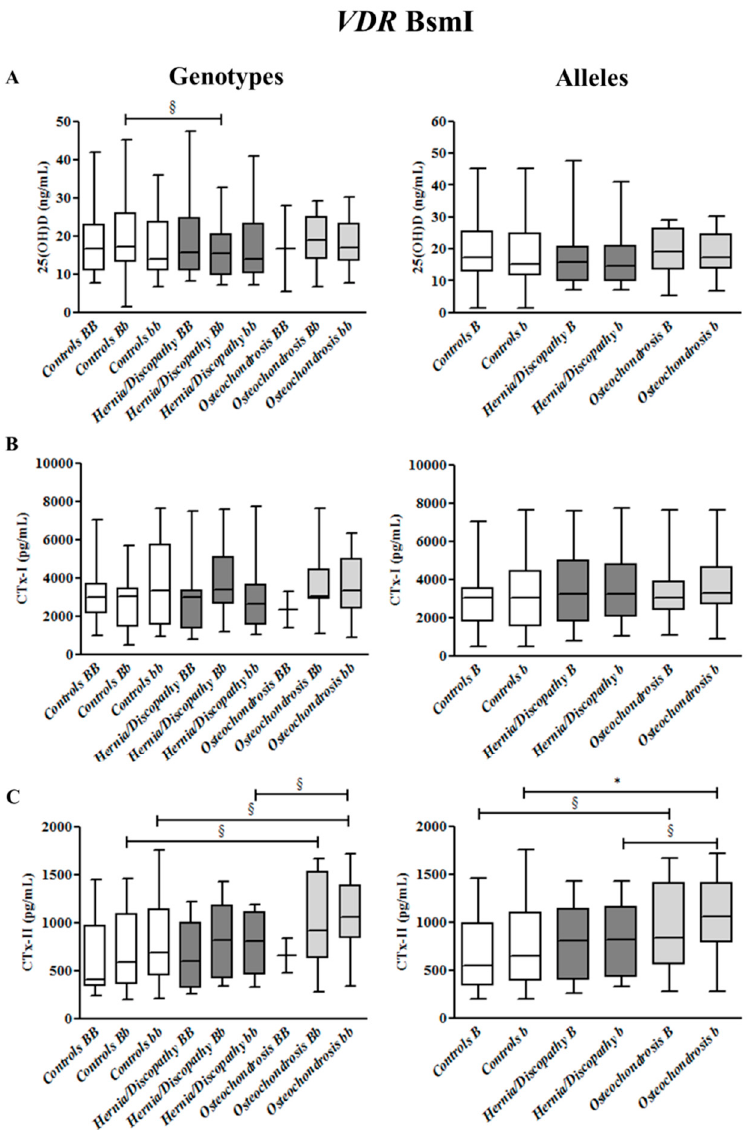
Figure 2. 25hydroxyvitamin D (25(OH)D) ( A ), cross-linked C-telopeptides of type I collagen (CTx-I) ( B ), and cross-linked C-telopeptides of type II collagen (CTx-II) ( C ) plasma concentrations in controls and in the subgroups of patients with hernia/discopathy and osteochondrosis, distributed according to BsmI VDR genotypes/alleles. The box and whisker plots show the median, 25th and 75th percentile (interquartile) (the box), and minimum and maximum value (the whiskers). * p < 0.05. § indicates a tendency.